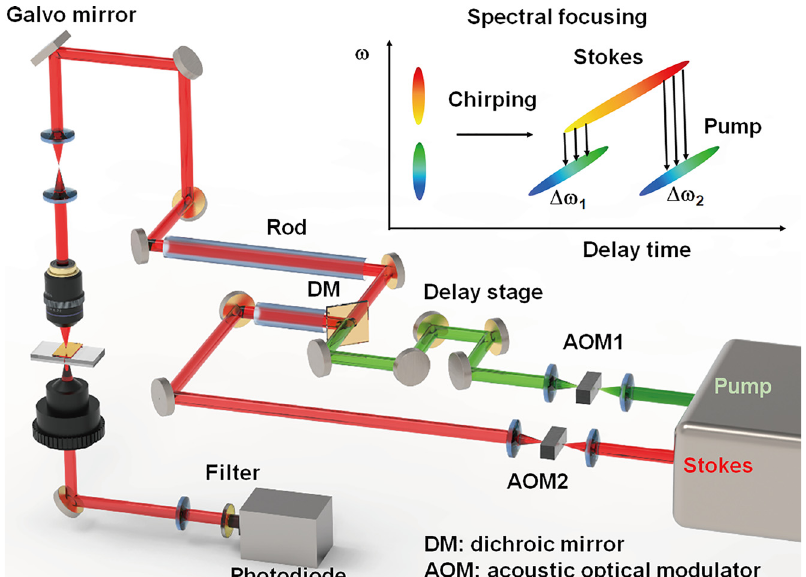
PESRS spectra from all pixels in the whole image were averaged. The raw PESRL and PESRG spectra of adenine are displayed in Figure 4. The resulting PESRL spectra (Figure 4a) from the adenine-adsorbed Au NPs aggregates